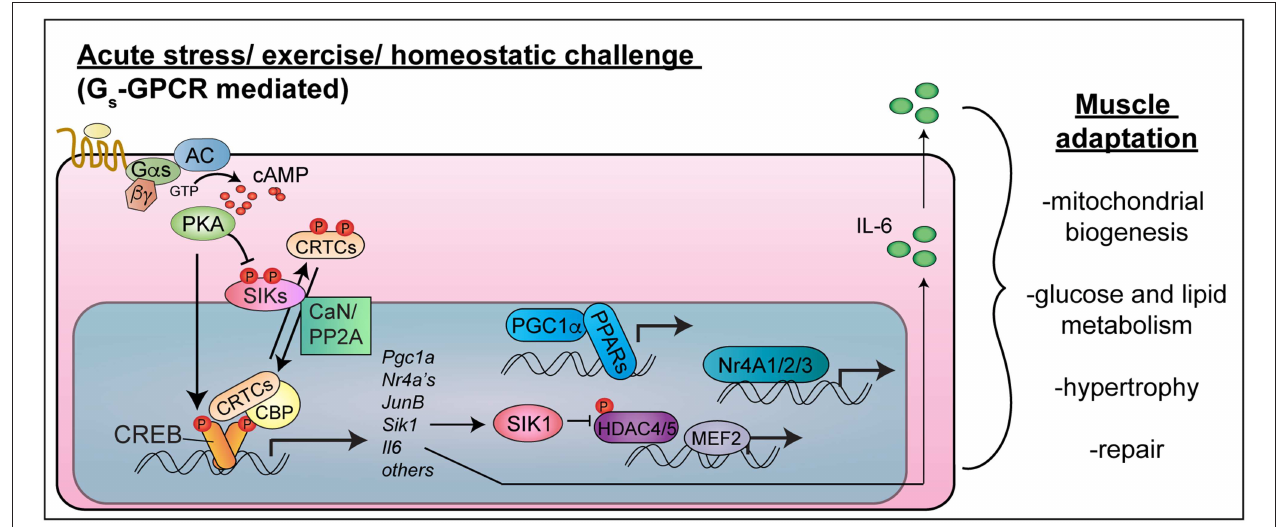
FIGURE 1 | CREB-CRTC function in skeletal muscle. Exercise or acute stress activates Gs-coupled GPCRs to stimulate cAMP-PKA signaling. PKA phosphorylates CREB in the nucleus, leading to CBP recruitment, and phosphorylates and inhibits SIKs, leading to CRTC de-phosphorylation in concert with phosphatase activation (CaN/PP2A). CREB-CRTC-CBP complexes activate target genes encoding transcription factors (PGC1-alpha, Nr4A family nuclear hormone receptors, JunB), signaling mediators (SIK1) and myokines (IL-6), which collectively stimulate mitochondrial biogenesis, improve nutrient uptake and metabolism, stimulate hypertrophy and allow muscle repair. Targeting these pathways in a muscle cell autonomous manner would be expected to have salutary effects on skeletal muscle health and function in type 2 diabetes and cancer cachexia (Note: the nucleus is not drawn to